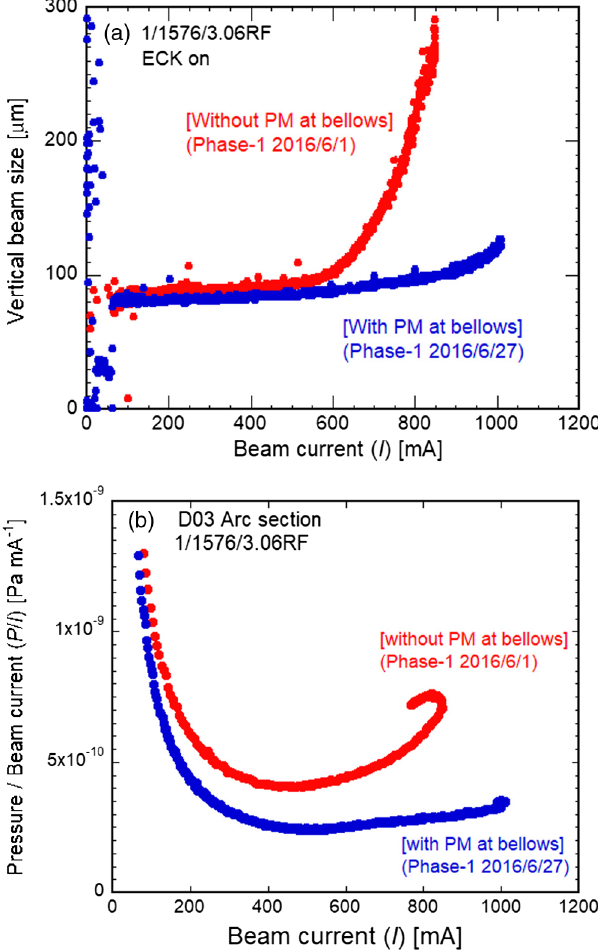
FIG. 3. Measured behaviors of (a) vertical beam size and (b) pressure in an arc section divided by beam current ( P=I ) against beam current ( I ) with and without permanent magnet (PM) units on Al-alloy bellow chambers for a bunch fill pattern of 1 = 1576 = 3 . 06